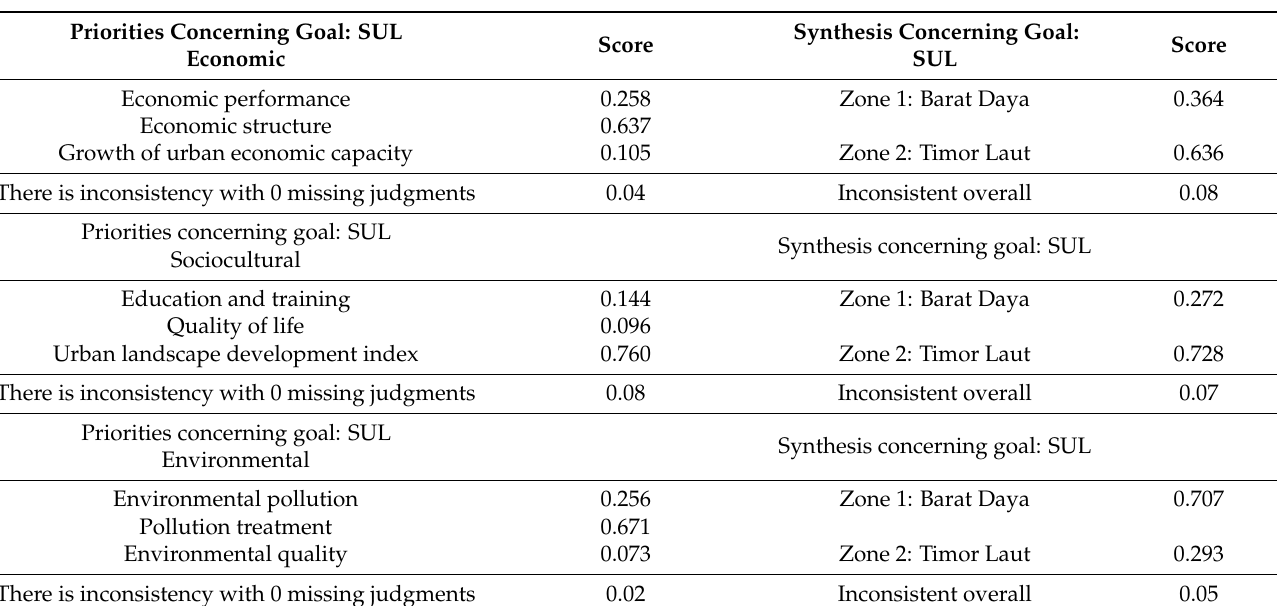
Table 5. Final weights for economic, sociocultural, and environmental criteria for the urban landscape.